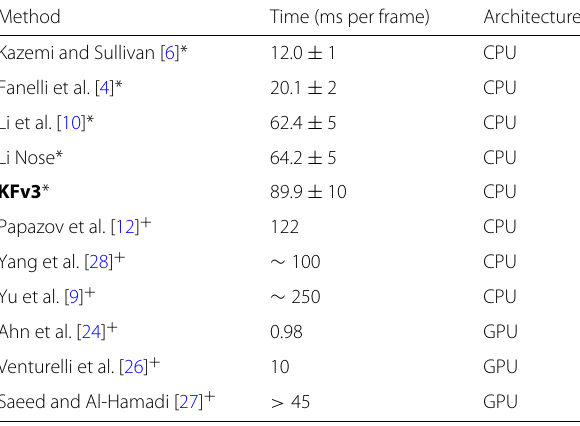
and faster, but they require the use a GPU card.